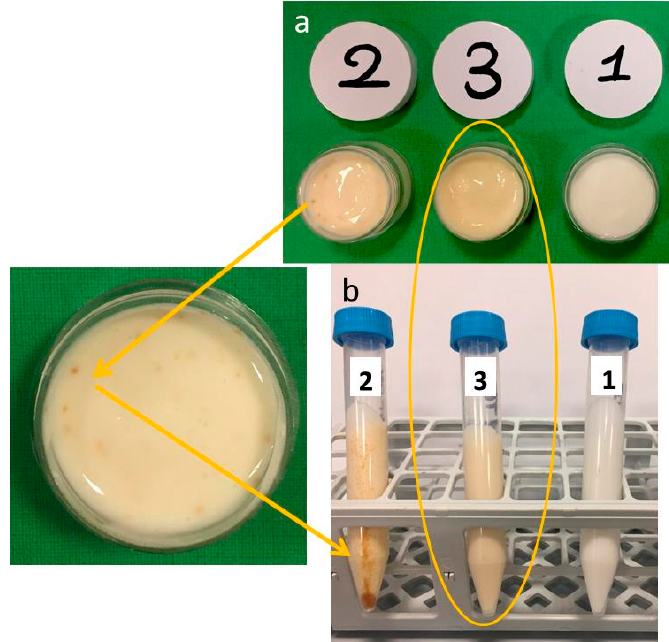
Figure 1. Macroscopic appearance of emulgel formulations before ( a ) and after ( b ) the centrifuge test (1 = blank emulgel; 2 = raw Milk Thistle Extract (MTE) emulgel; 3 = MTE-mp emulgel).